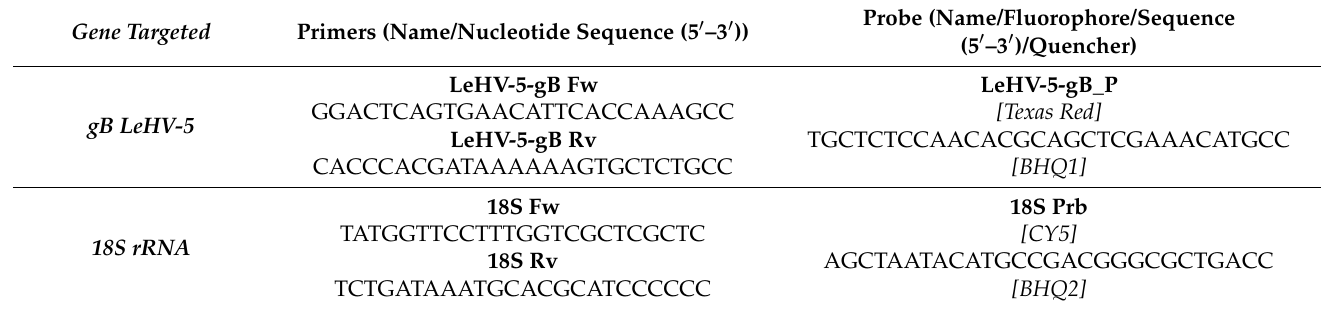
Table 1. Primers and probes designed for the qPCR systems. Gene